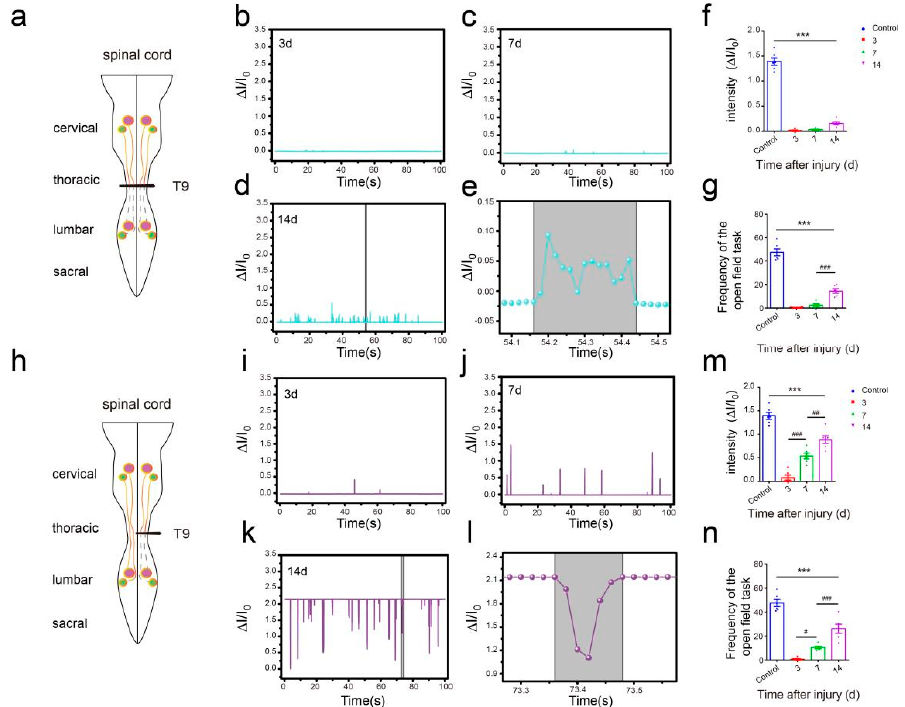
Figure 6. Hindlimb locomotion in open field task (SCI mice). ( a ) The pattern of the spinal cord (complete spinal transection). ( b ) Hindlimb locomotion of complete spinal transection mice and its corresponding relative current (SCI 3d). ( c ) Hindlimb locomotion of complete spinal transection mice and its corresponding relative current (SCI 7d). ( d ) Hindlimb locomotion of complete spinal transection mice and its corresponding relative current (SCI 14d). ( e ) An enlarged view of complete SCI 14d mouse (from Figure 6d). ( f ) Intensity of complete spinal transection mice ( n = 6). ( g ) Frequency of complete spinal transection mice ( n = 6). ( h ) The pattern of spinal cord (unilateral thoracic SCI). ( i ) Hindlimb locomotion of unilateral thoracic SCI mice and its corresponding relative current (SCI 3d). ( j ) Hindlimb locomotion of unilateral thoracic SCI mice and its corresponding relative current (SCI 7d). ( k ) Hindlimb locomotion of unilateral thoracic SCI mice and its corresponding relative current (SCI 14d). ( l ) An enlarged view of unilateral thoracic SCI 14d mouse (from Figure 6k). ( m ) Intensity of unilateral thoracic SCI mice ( n = 6). ( n ) Frequency of unilateral thoracic SCI mice ( n = 6). One-way repeated-measures AVOVA and post hoc Bonferroni tests were applied. *** p < 0.001 (compared with control mice), # p < 0.05, ## p < 0.01, ### p < 0.001 (compared with SCI 7d mice), error bars,